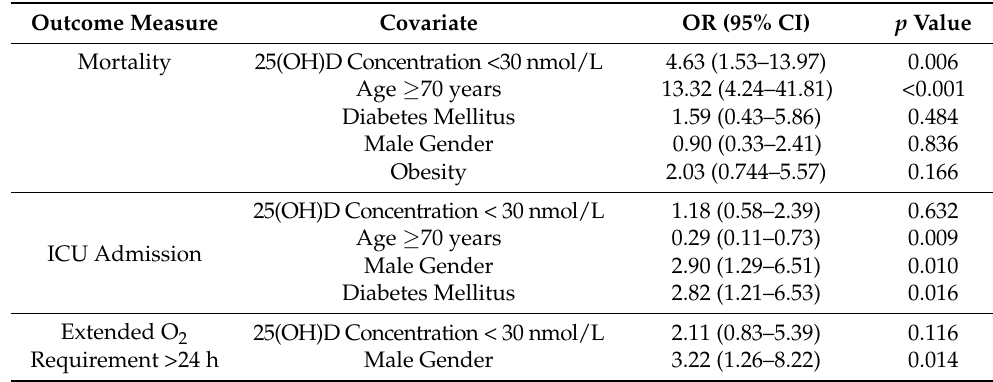
Table 5. Multivariable logistic regression analyses predicting mortality, ICU admission and O 2 requirement with 25(OH)D status < 30 nmol/L while controlling for confounding